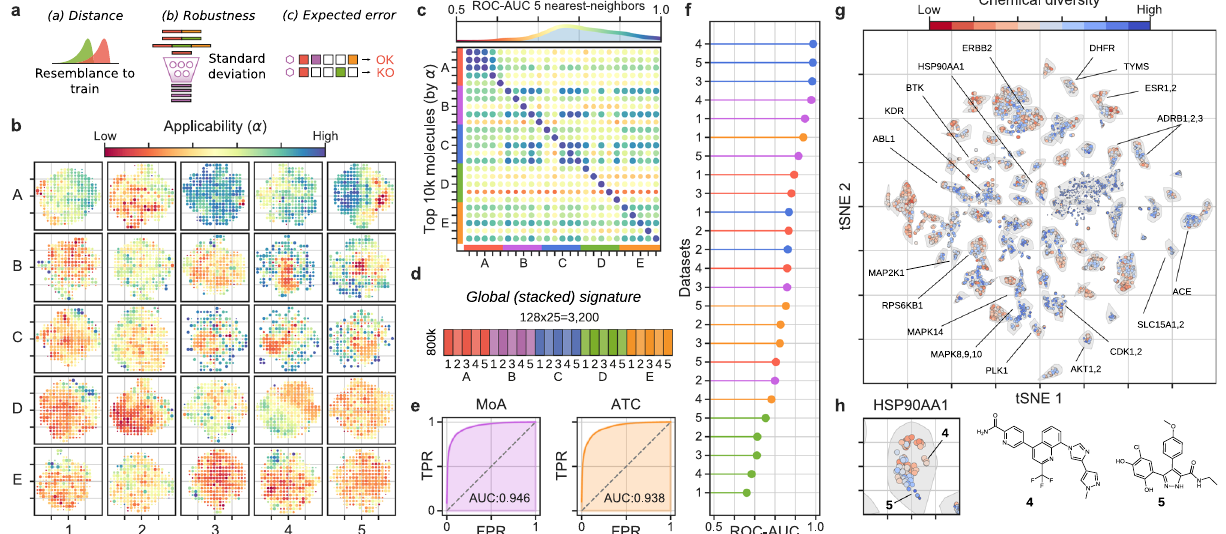
Fig. 2 Large-scale bioactivity prediction using the signaturizers (~800k molecules). a Features combined to derive the applicability scores ( α ). b Applicability scores for the predictions, displayed across the 25 (A1-E5) 2D-projected signature maps. A grid was de fi ned on the 2D coordinates, molecules were binned and the average α is plotted in a red (low) to blue (high) color scale. c Cross-correlation between CC spaces, de fi ned as the capacity of similarities measured in S i (rows) to recall the top-5 nearest neighbors in S j (columns) (ROC-AUC), the color scale goes from red to blue indicating low to high cross-correlation (also reported as dot size). Top 10k molecules (sorted by α ) were chosen as S i . d Scheme of the signature stacking procedure. Signatures can be stacked horizontally to obtain a global signature (GSig) of 3200 dimensions. e Ability of similarity measures performed in the GSig space to identify pairs of molecules sharing the Mode of action (MoA left) or therapeutic classes (ATC code right) (ROC-AUC). f Likewise, the ability of GSigs to identify the nearest neighbors found in the experimental (original) versions of the A1-E5 data sets. g t-SNE 2D projection of GSigs. The 10k molecules with the highest average α across the 25 signatures are displayed. The cool-warm color scale represents chemical diversity, red meaning that molecules in the neighborhood are structurally similar (Tanimoto MFp similarity between the molecule in question and their 5-nearest neighbors). A subset of representative clusters is annotated with enriched binding activities. h Example of a cluster enriched in heat shock protein 90 inhibitors (HSP90AA1) with highlighted representative molecules with distinct ( 4 ) or chemically related ( 5 ) neighbors in the